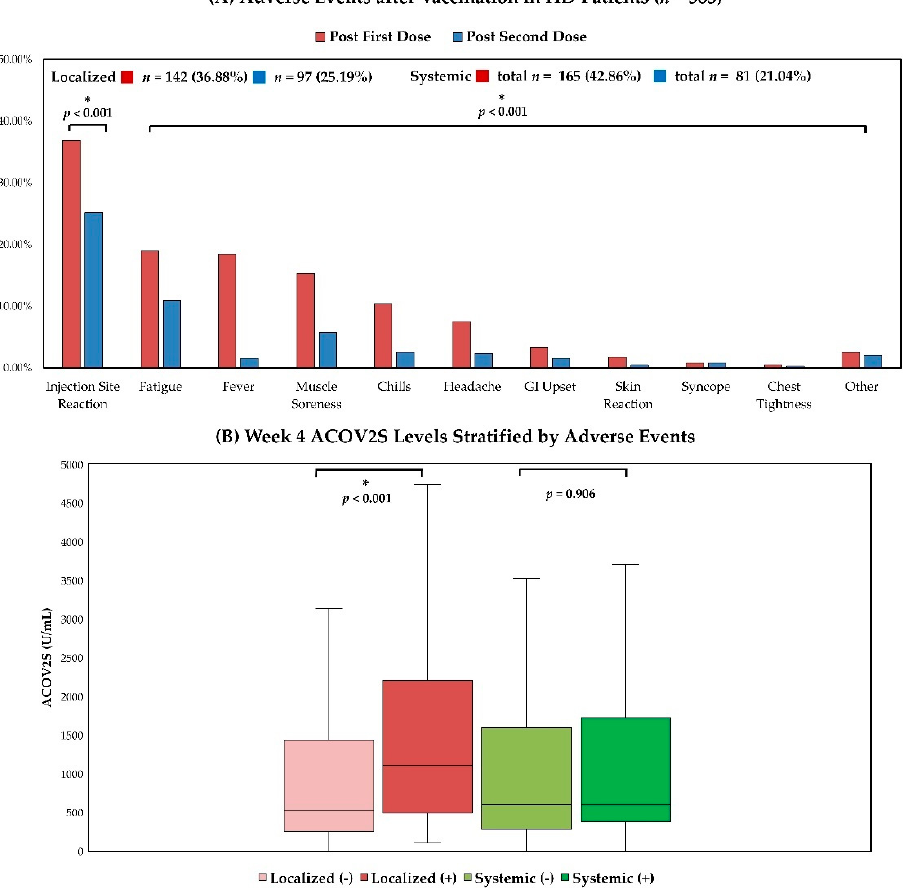
Figure 3. The Adverse Events after Vaccination and their Associations with Humoral Responses in HD Patients ( n = 385) ( A ) Adverse events after vaccination in HD patients; ( B ) Week 4 ACOV2S levels stratified by adverse events after second dose of vaccination in HD patients. The adverse events after first and second doses of vaccination were as follows: injection site reaction, such as pain, redness, or swelling, n = 142 (36.88%) and 97 (25.19%); fatigue/dizziness, n = 73 (18.97%) and 42 (10.91%); fever, n = 71 (18.44%) and 6 (1.56%); muscle soreness/arthralgia, n = 59 (15.32%) and 22 (5.71%); chills, n = 40 (10.39%) and 10 (2.60%); headache, n = 29 (7.53%) and 9 (2.34%); GI upset, n = 13 (3.38%) and 6 (1.56%); skin reaction, such as rash, petechiae, or ecchymosis, n = 7 (1.82%) and 2 (0.52%); syncope/hypotension, n = 3 (0.78%) and 3 (0.78%); chest tightness, n = 2 (0.52%) and 1 (0.26%); and other events, such as rhinorrhea/pruritus/blurred vision/elevated blood pressure/insomnia, n = 12 (2.60%) and 8 (2.08%). GI, gastrointestinal. *: p <